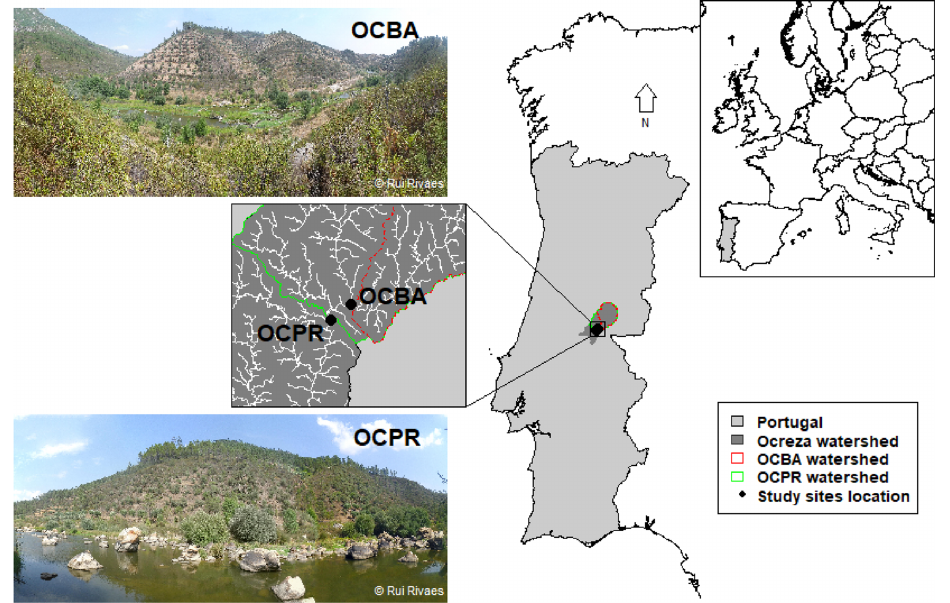
Figure 1. Location and characterization of the study sites OCBA and